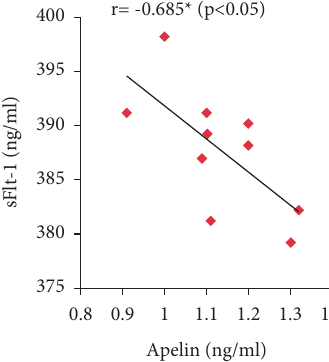
Figure 11: Correlation between serum apelin and sFlt-1 in the PE